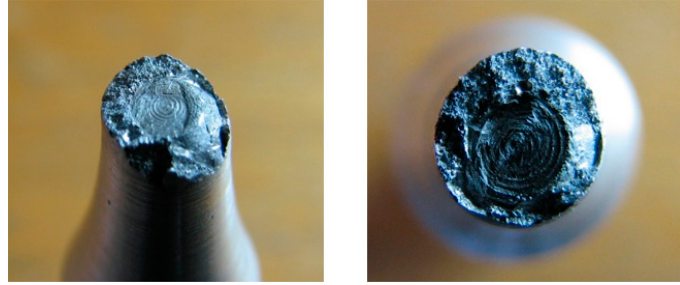
Figure 8. Macrostructure of the fracture areas with the alpha-geometry of the weld surface.